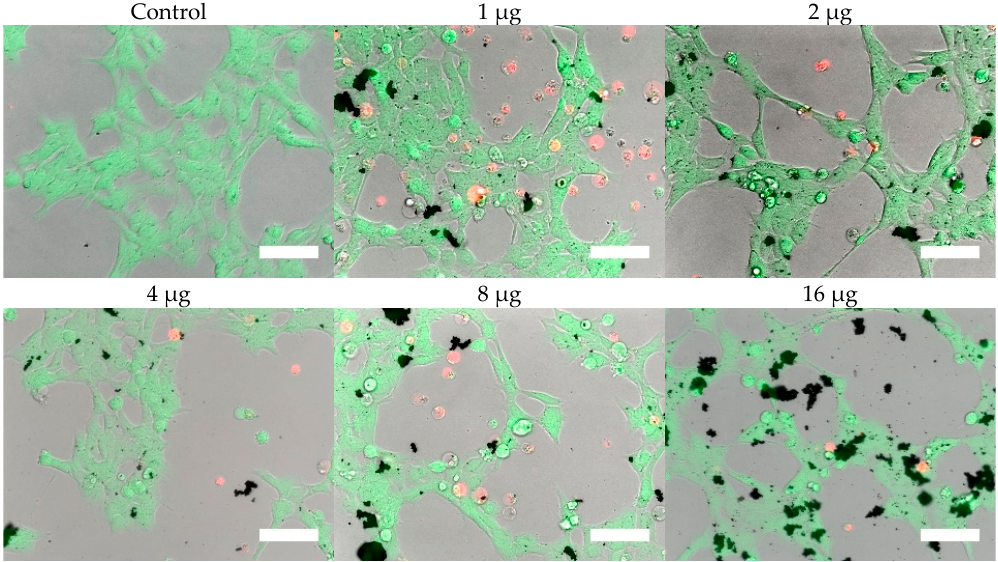
Figure 9. LIVE/DEAD assay results of RVM cells treated with hydrophobic iron oxide nanoparticles after 24 h. Calcein (green) indicates live cells while ethidium homodimer-1 (red) indicates dead cells. Scale bar = 50 µm.